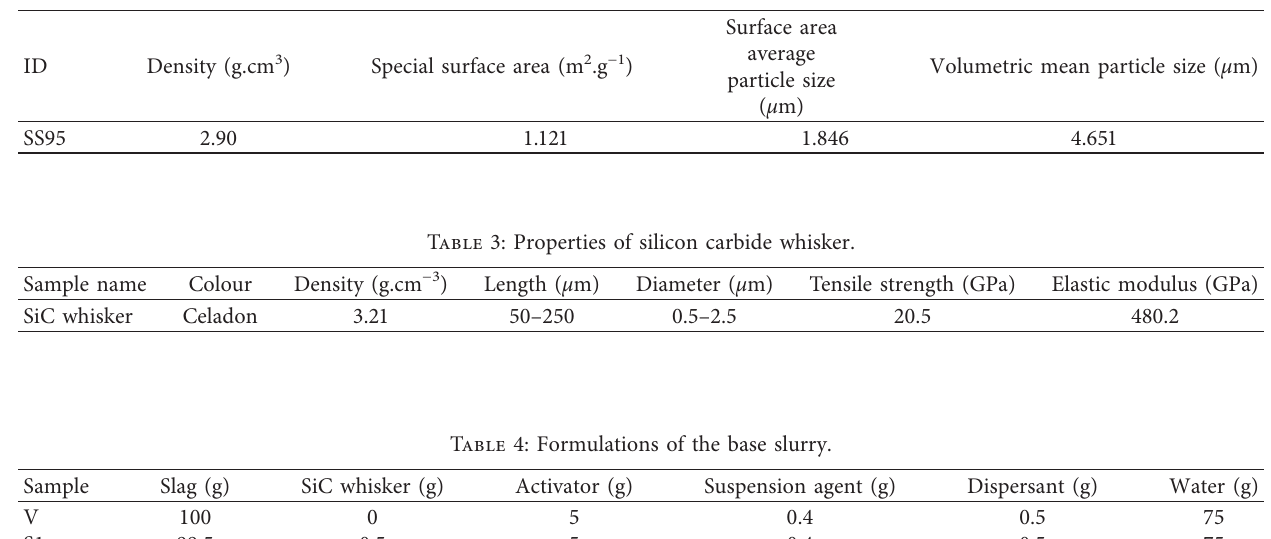
Table 2: Properties of slag particles.